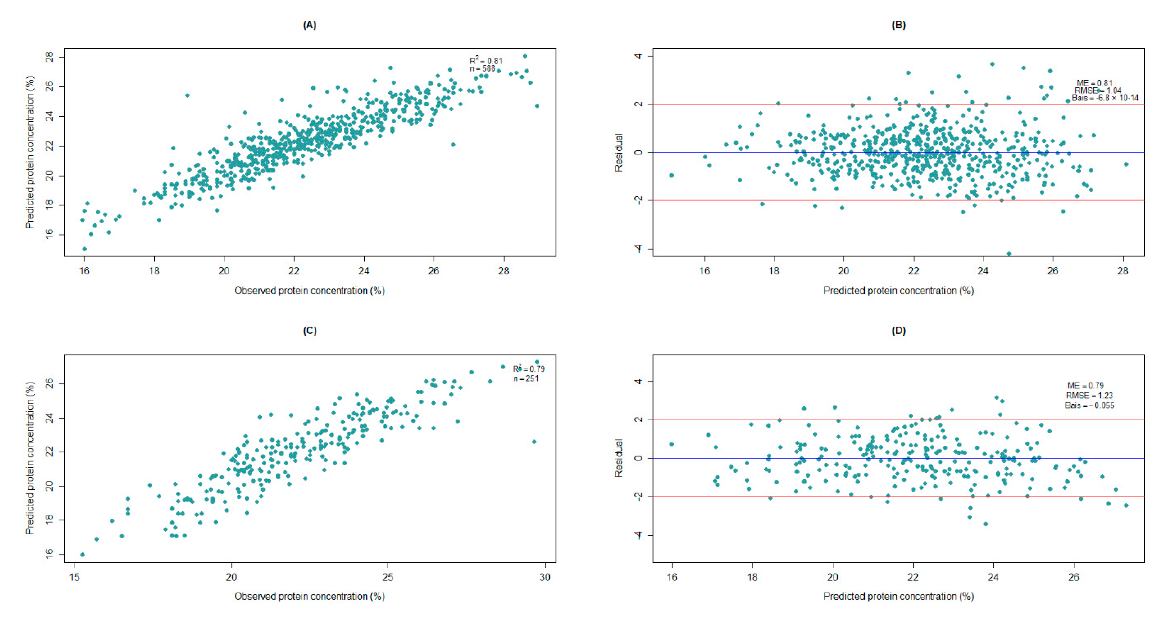
Figure 5. Different plots for partial least square regression (PLSR) using FT9700 spectral data: ( A ) scatter plot of predicted values against observed values for the calibration set, ( B ) plot of residual values against predicted values for the calibration set, ( C ) scatter plot of predicted values set against observed values for the validation, and ( D ) plot of residual values against predicted values for the validation set.